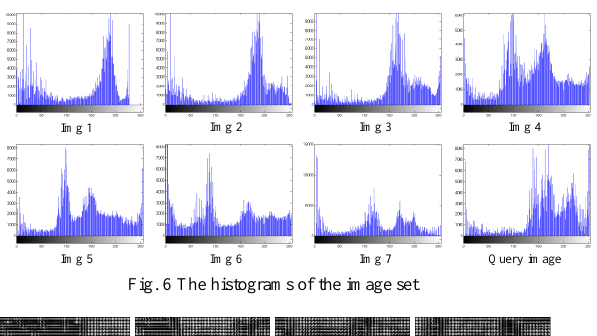
Fig. 6 The histograms of the image set